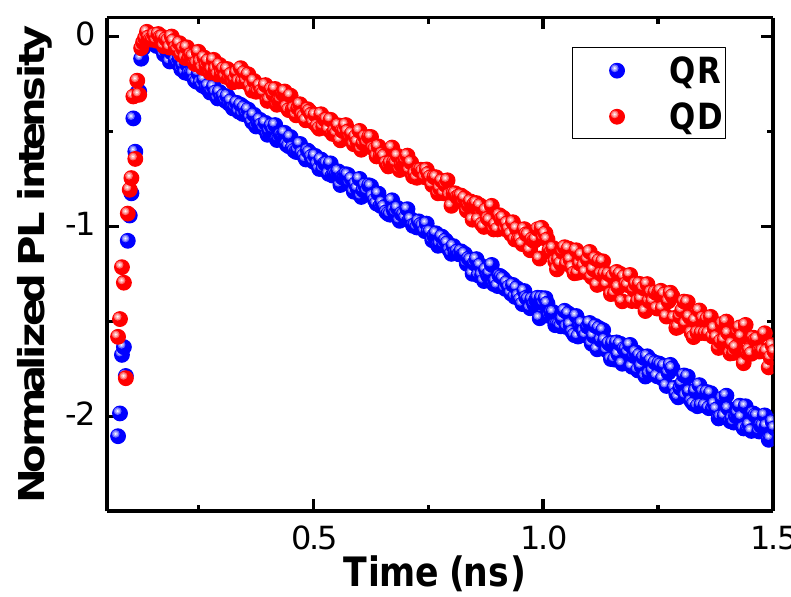
Figure 4. Time-resolved PL spectra at 4 K for comparing the carrier dynamics of the QR and QD. The PL decay curves for the two structures exhibit different decay behaviors.